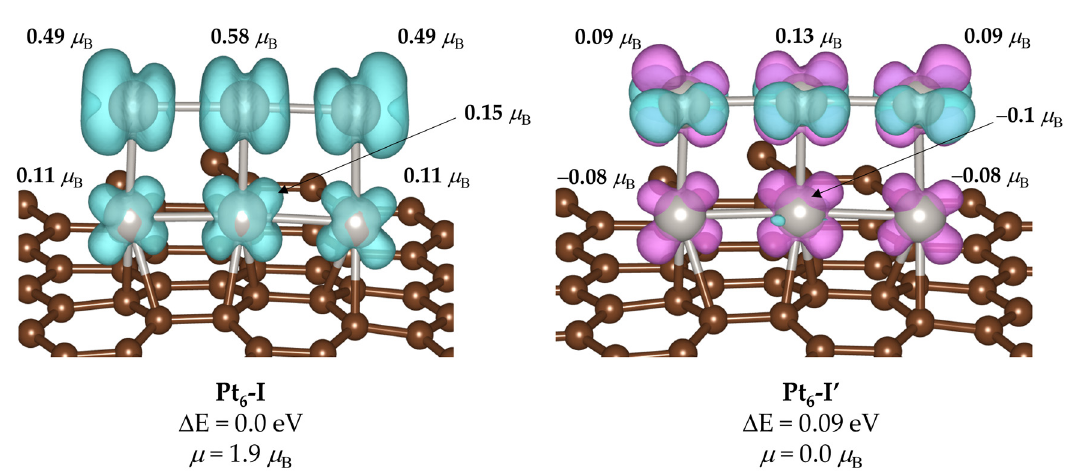
Figure 2. Spin density, total and individual atomic magnetic moments, and energy different for the two low ‐ lying spin states of Pt 6 ‐ I. Note that α spin density is shown in light blue and β spin density in light pink (isovalue = 0.03 au).